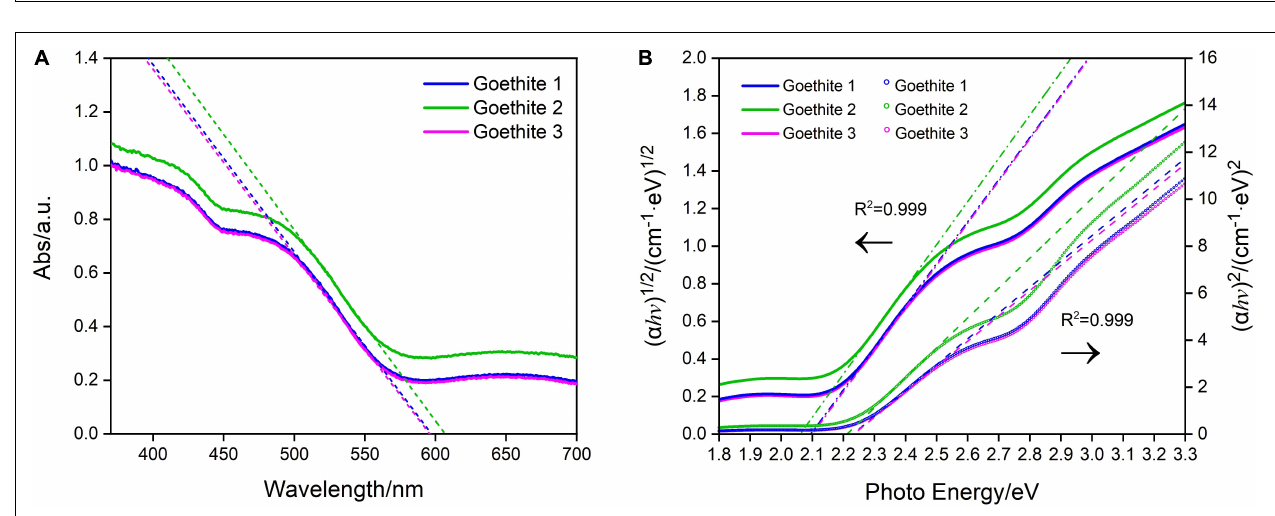
FIGURE 2 | Environmental scanning electron microscope images (A) and EDS (B) of synthetic goethite.